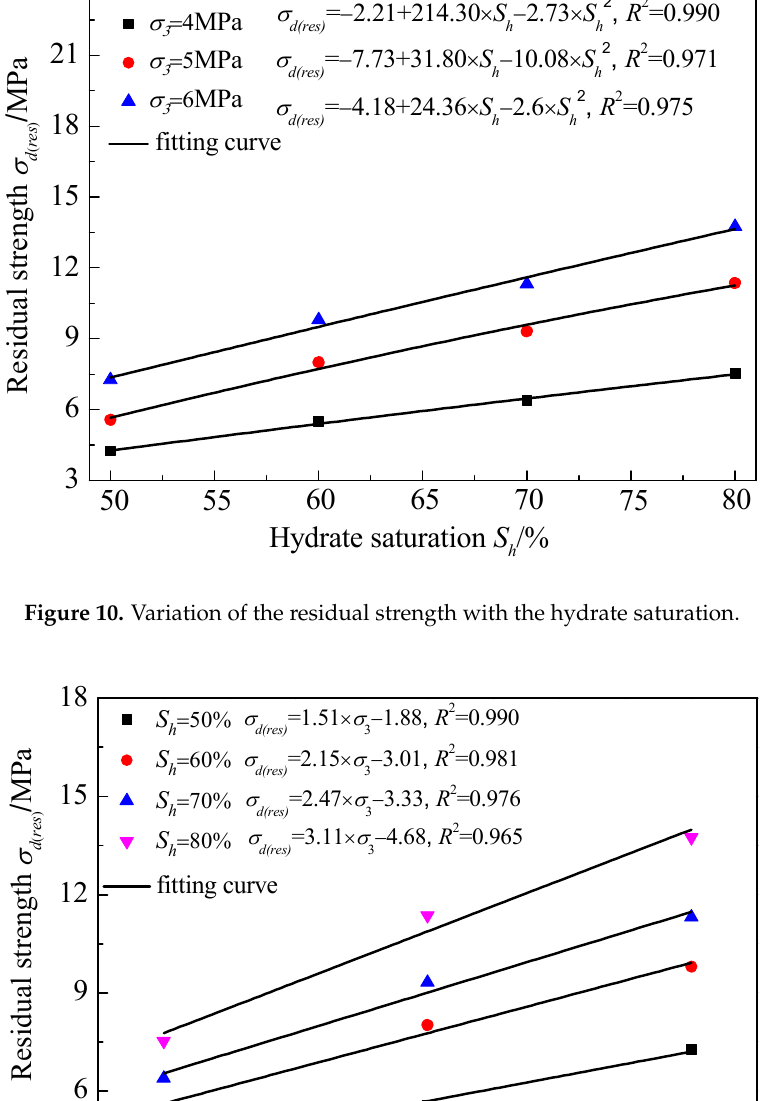
Figure 12. Residual deviator stress versus maximum deviator stress at various methane hydrate saturations and confining pressure during testing.